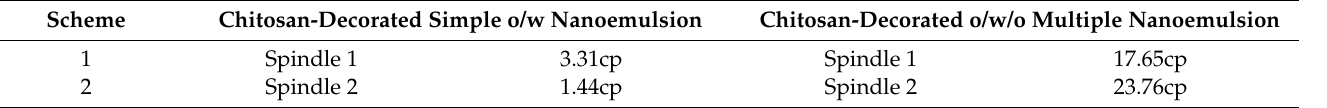
Table 4. Viscosity of formulated nanoemulsions.